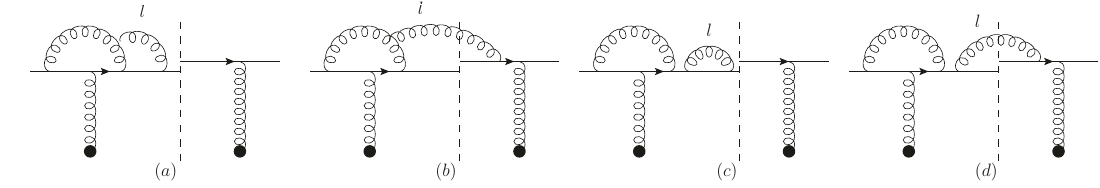
Figure 5 . Sample diagrams contributing to the BK kernel at two loop order. The di(cid:11)erent pole contributions from (cid:12)gure 5a and (cid:12)gure 5b are completely canceled out within the double leading logarithm accuracy, while the incomplete cancellation between (cid:12)gure 5c and (cid:12)gure 5d gives rise to the partial double leading logarithm NLO correction to the virtual part of the LO BK